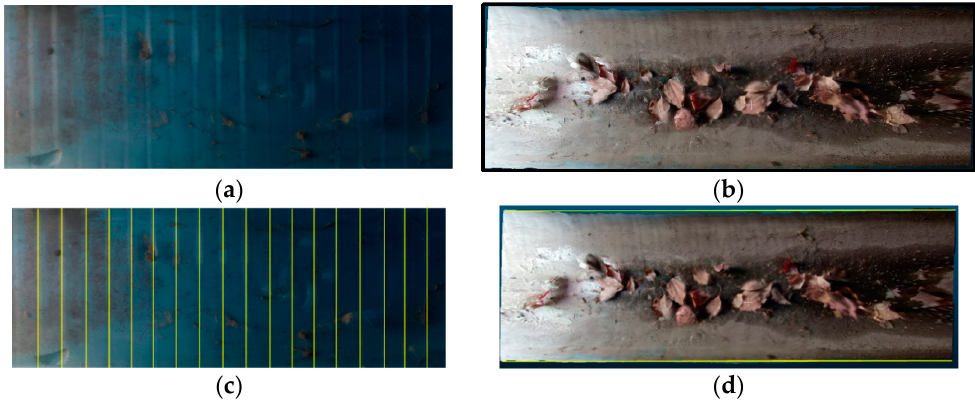
Figure 10. Model details ( a , b ) and relative accuracy analysis ( c , d ).